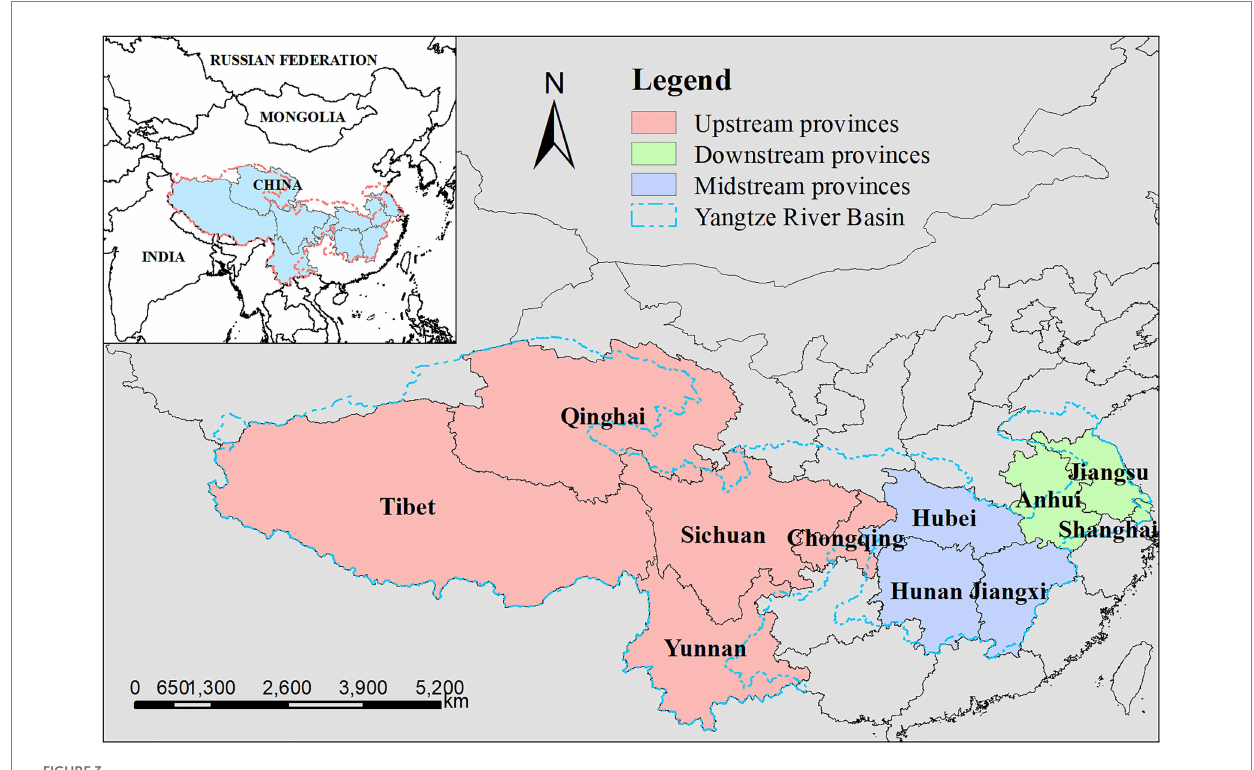
FIGURE 3 The location of the target study